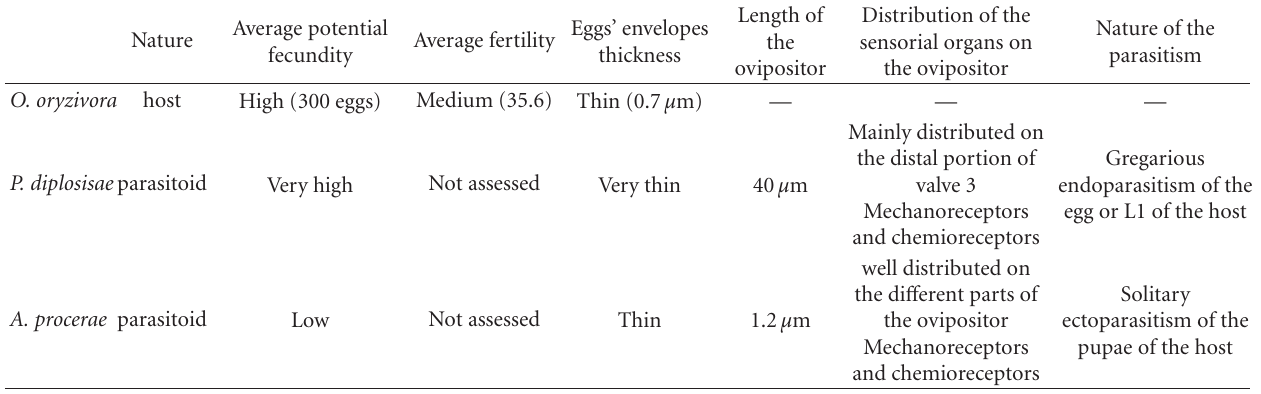
Table 3: Main biological features of O. oryzivora (host), Platygaster diplosisae , and Aprostocetus procerae (parasitoids). (According to Nacro and N´enon,